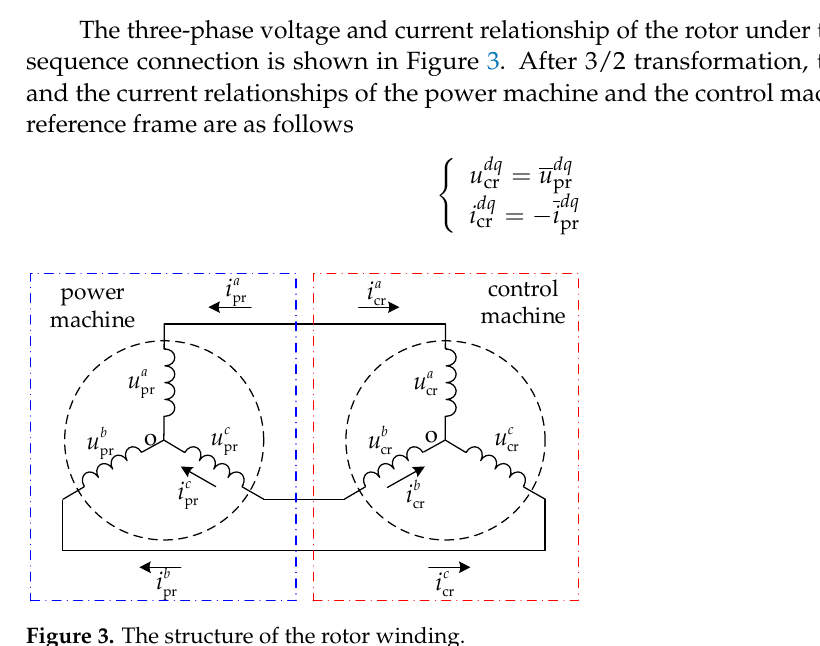
Figure 3. The structure of the rotor winding.